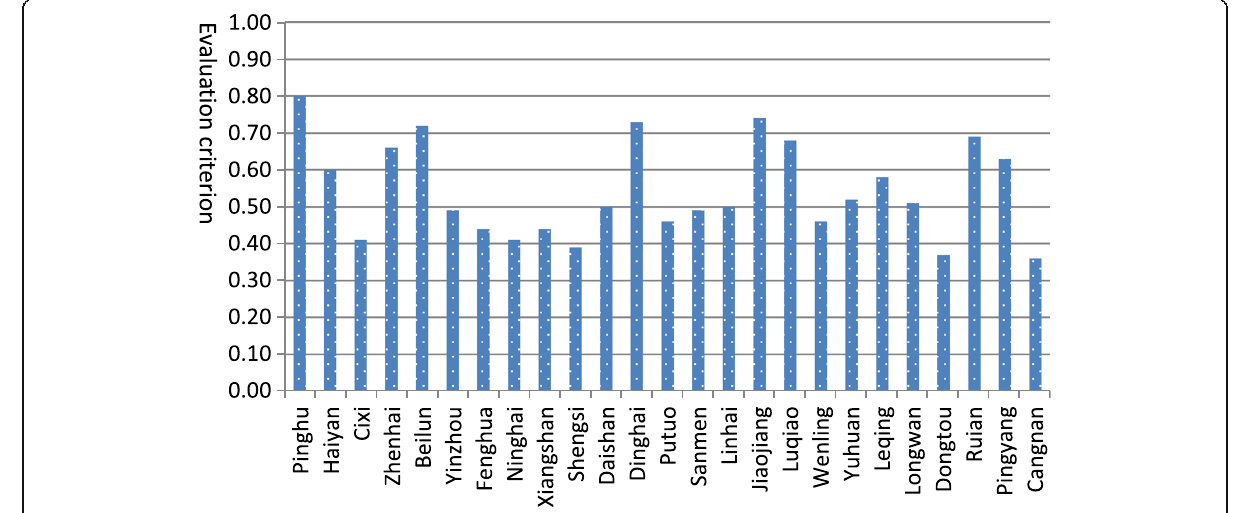
Fig. 4 Twenty-five sections evaluation criterion for coastline of Zhejiang